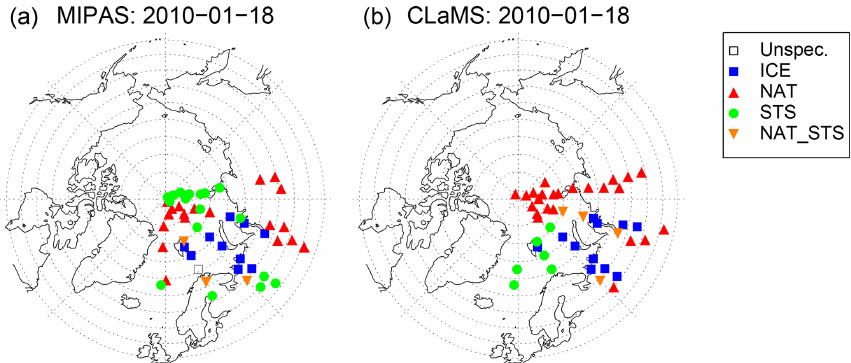
Figure 4. Horizontal distribution of MIPAS (a) and CLaMS (b) PSC composition classes for 18 January 2010 at an altitude level of 500K ( ± 20K) potential